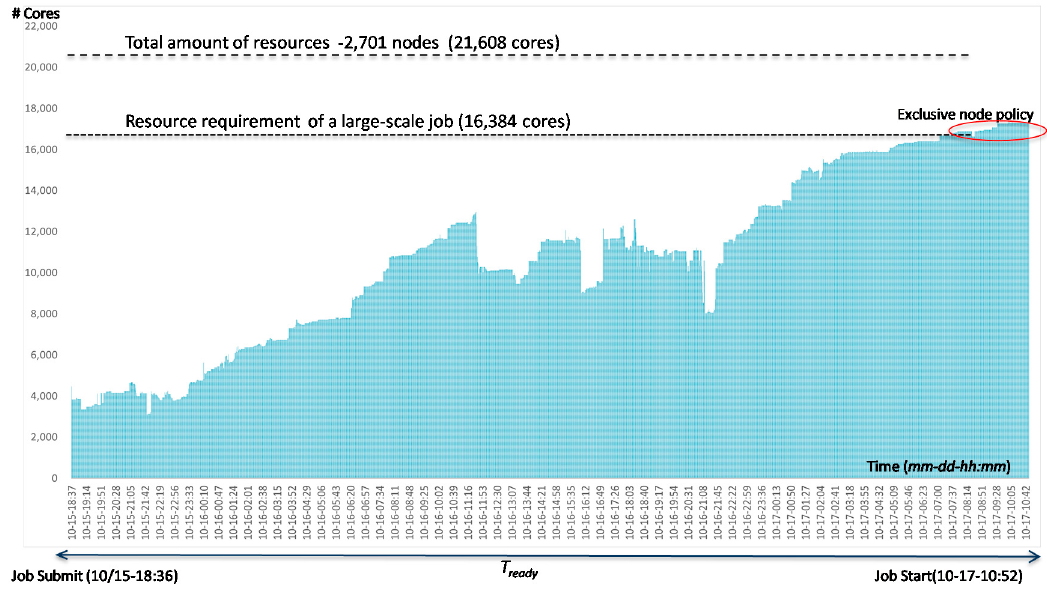
Figure 7. Increase in available resources for the resource allocation of large jobs.